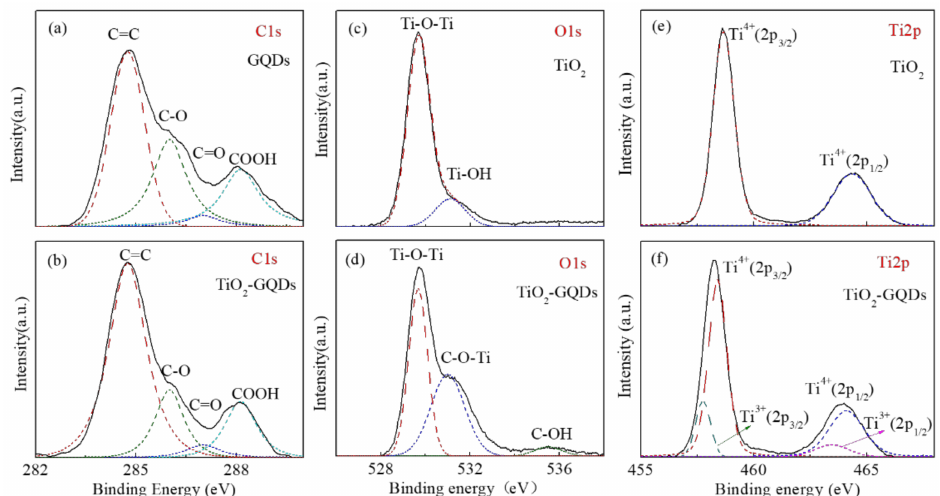
Figure 5. High-resolution XPS spectra of samples: ( a , b ) C1s spectra for GQDs and TiO 2 -GQDs caterpillar hybrid, ( c , d ) O1s, and ( e , f ) Ti2p for TiO 2 caterpillar and TiO 2 -GQDs caterpillar